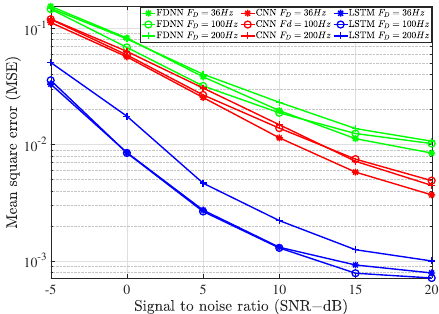
Figure 16. The impact of the Doppler frequency on the deep learning-based channel estimations.